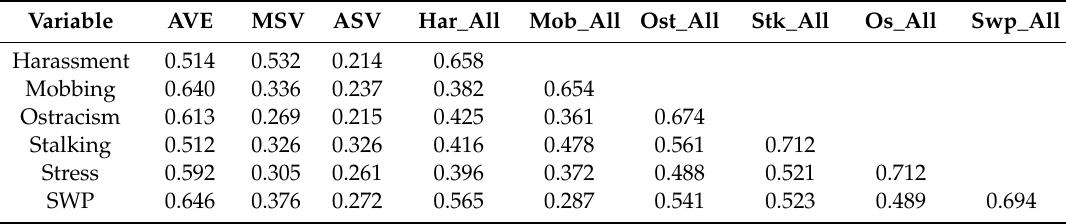
Table 4. Construct reliability and validity.